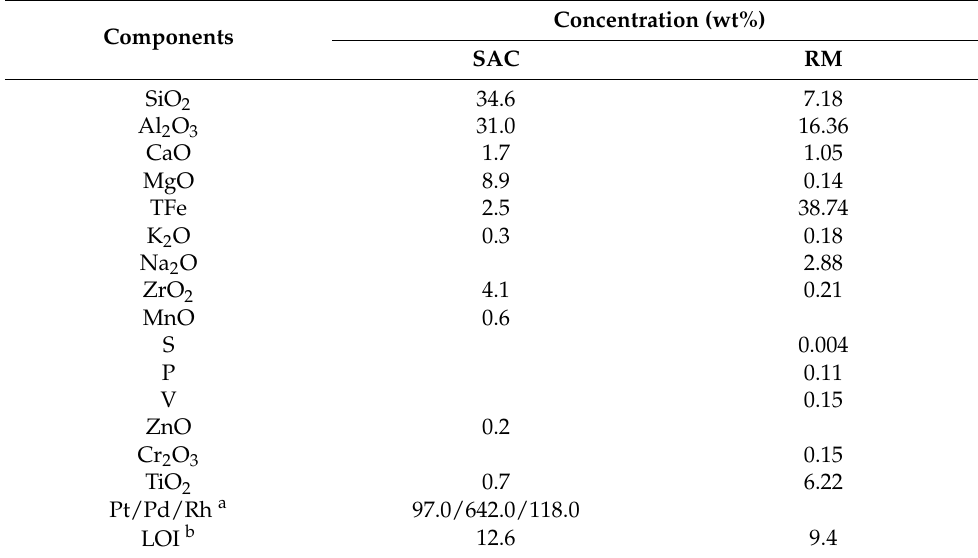
Table 1. Chemical compositions of the SAC and RM used for the experiments.